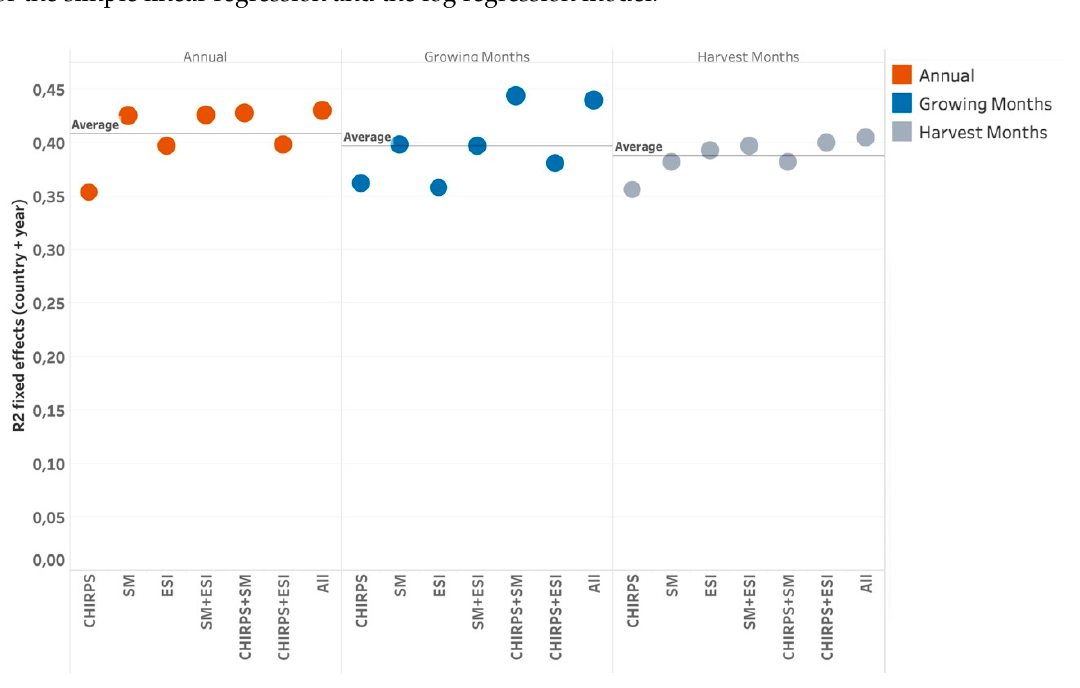
Figure 7. R-squared for all combinations of moisture variables for annual averages of all satellite-derived variables, averages only for maize-growing months (blue) and maize-harvesting months (grey); annual maize yield is the dependent variable.